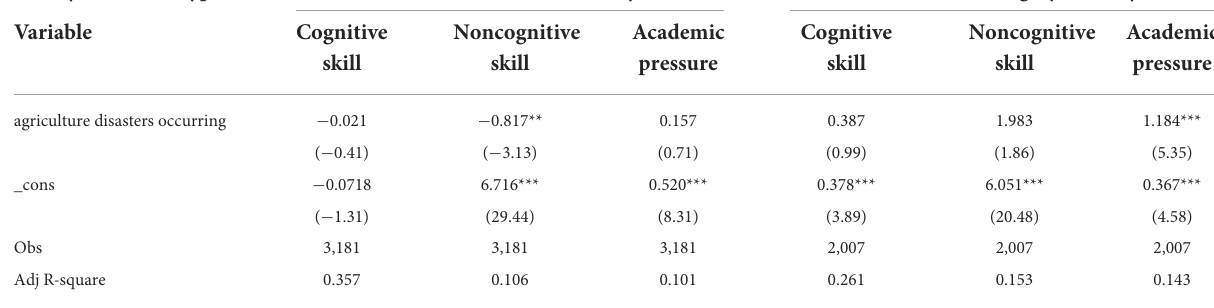
TABLE 4 The results of different parents concerns heterogeneity analysis. Family education types Parents think little of study Variable Cognitive Noncognitive